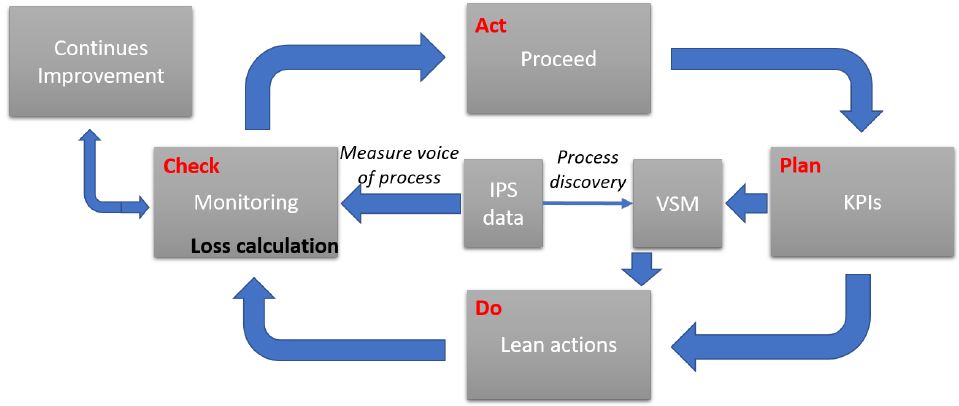
Figure 2. IPS data is the key element of the proposed PDCA-cycle-based